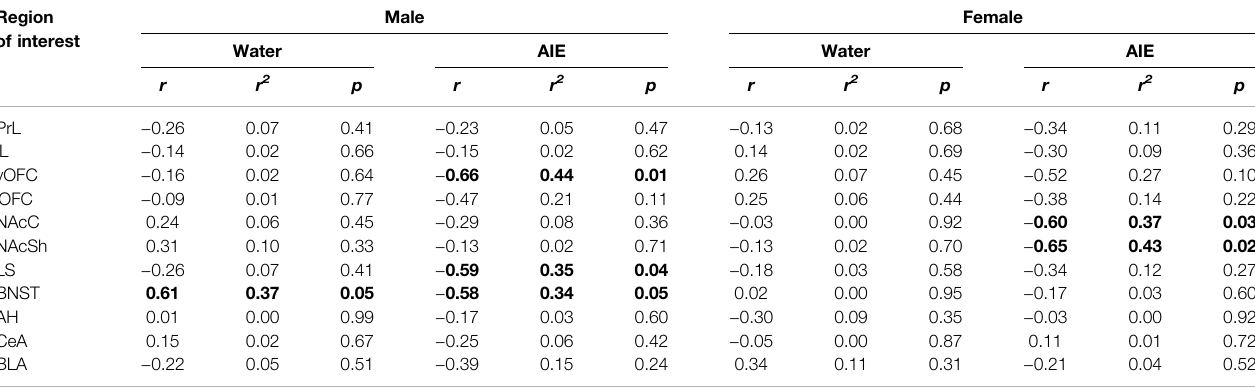
TABLE2| Therelationshipbetweensocialpreference/avoidancecoef fi cientandthenumberof β -galpositivecellsforeachregionofinterestofwaterandAIEexposedmales and females assessed with Pearson correlation and linear regression analyses. Region of interest